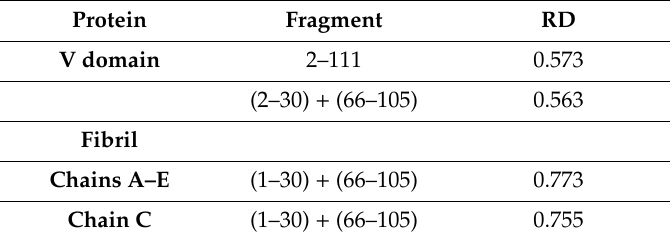
Table 6. The status of the V domain structural forms discussed in this work is expressed by the value of RD parameters determined for the respective fragments of single chains and as part of fibril.